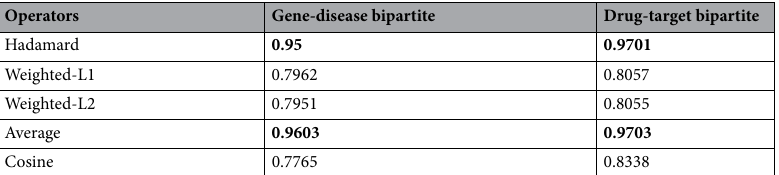
Table 6. ROC-AUC scores for link prediction using MultiVERSE on 2 multiplex-heterogeneous reference networks. Link predictions are computed for the bipartite interactions of the multiplex-heterogeneous networks. The scores higher than 0.9 are highlighted in